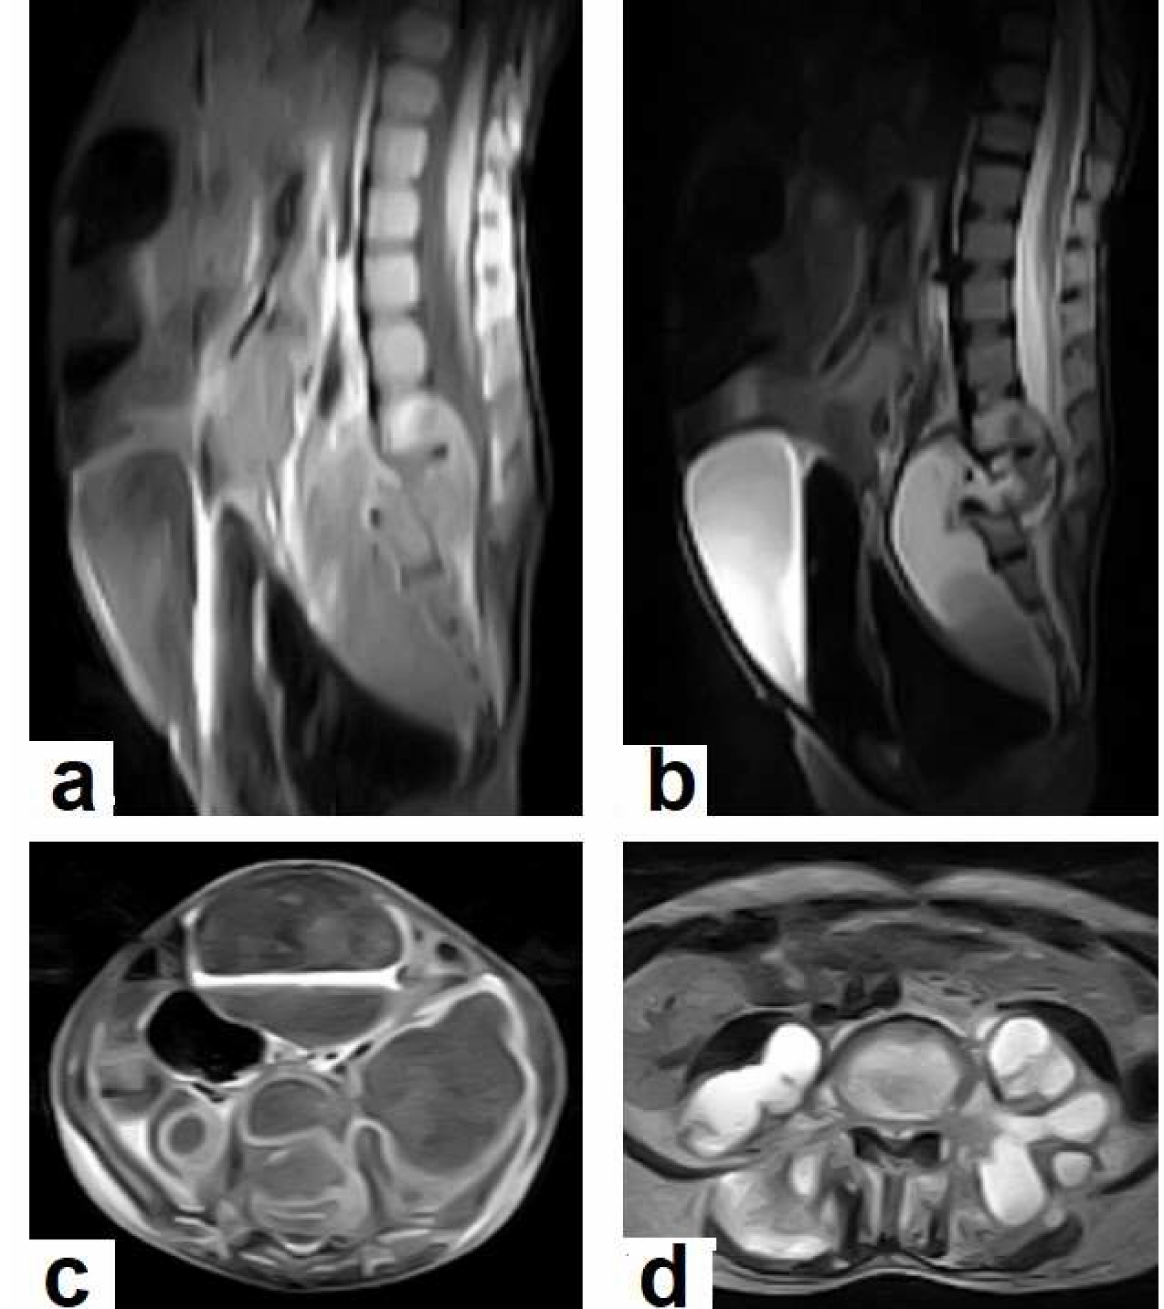
Figure 19. Pott’s disease in a 6-year-old female patient. Selected images of lumbosacral MRI. Sagittal ( a ) T1-weighted images and ( b ) T2-weighted images show that destructive lesion involves the T4/T5 disc and vertebrae, with extensive pre-vertebral loculated fluid collection. Selected axial images of MRI ( c ) T1-weighted image with gadolinium, and ( d ) T2-weighted image shows bilateral paravertebral loculated fluid collections involved in bilateral psoas; paravertebral muscles appear to have low-signal-intensity contents on T1-WIs with marginal enhancement after contrast administration and high-signal-intensity contents on T2-WIs (arrows). The picture is typical of Pott’s disease with bilateral psoas and paravertebral abscesses. Other rare forms of CNS TB include pachymeningitis, tuberculous encephalopathy in children, cerebral vasculitis, tuberculoma in plaque, tuberculous transverse myelitis,